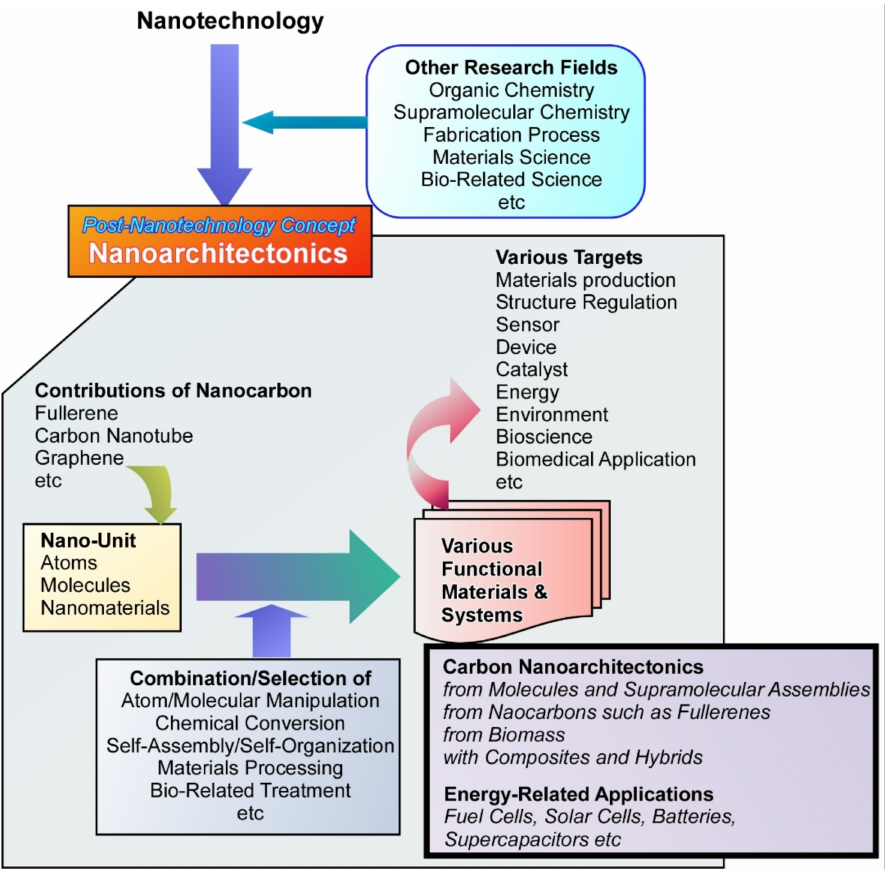
Figure 1. Outline of nanoarchitectonics concept to produce functional materials from nanoscale units with highlights of carbon nanoarchitectonics and its energy-related